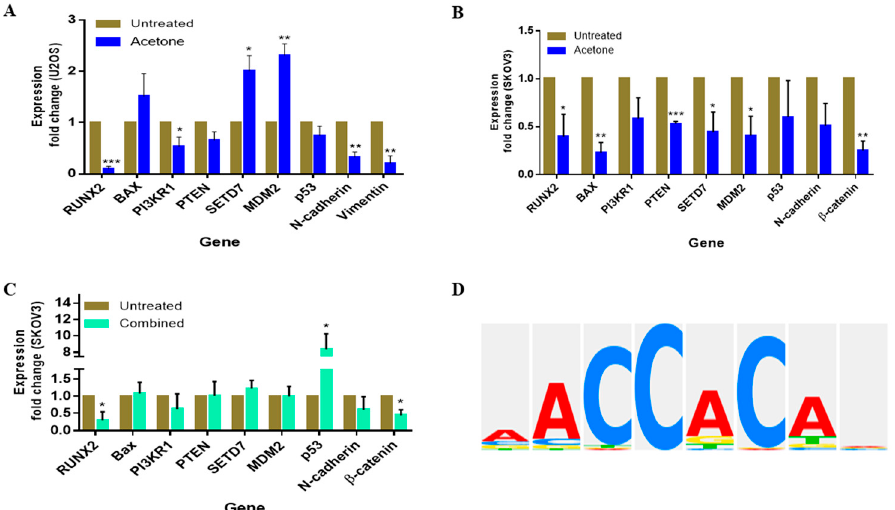
Figure 8. S. triloba acetone extract and its combination with paclitaxel affect the steady-state mRNA expression of both U2OS and SKOV3 cells. The steady-state mRNA expression of genes involved in cell proliferation and migration was examined using qPCR after cells were treated with S. triloba acetone extract (IC 50 ) for 48 h. ( A ) Significant decreases in U2OS gene expression were observed for RUNX2 , PI3KR1 , N-cadherin and vimentin genes, while SETD7 and MDM2 were significantly upregulated. The greatest increase (approx. 2 fold) in expression was observed for both SETD7 and MDM2 genes while RUNX2 exhibited the highest decline (91%) in expression. ( B ) Statistically significant declines in gene expression were observed for RUNX2 , BAX , PTEN , SETD7 , MDM2 , and β -catenin in SKOV3 cells; none of the tested genes were upregulated after S. triloba treatment. ( C ) When SKOV3 cells were treated with the combination treatment (19 µg/mL S. triloba + 0.787 µg/mL paclitaxel), RUNX2 and β -catenin expression was significantly downregulated, while p53 expression was significantly upregulated; p53 exhibited notable upregulation with an expression fold change of approx. 8. Results are a representation of three independent experiments (*** p ≤ 0.001, ** p ≤ 0.01, * p ≤ 0.05). ( D ) Consensus sequence of RUNX2 transcription factor binding site (TFBS) within the MDM2 promoter region obtained from the TRANSFAC ® database.